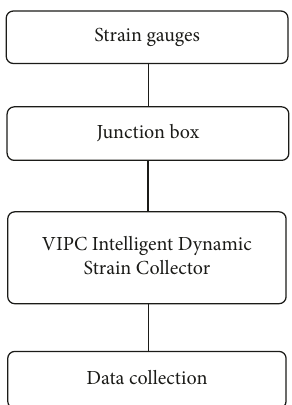
Figure 2: Schematic diagram of the site layout for the data col- lection of the dynamic load